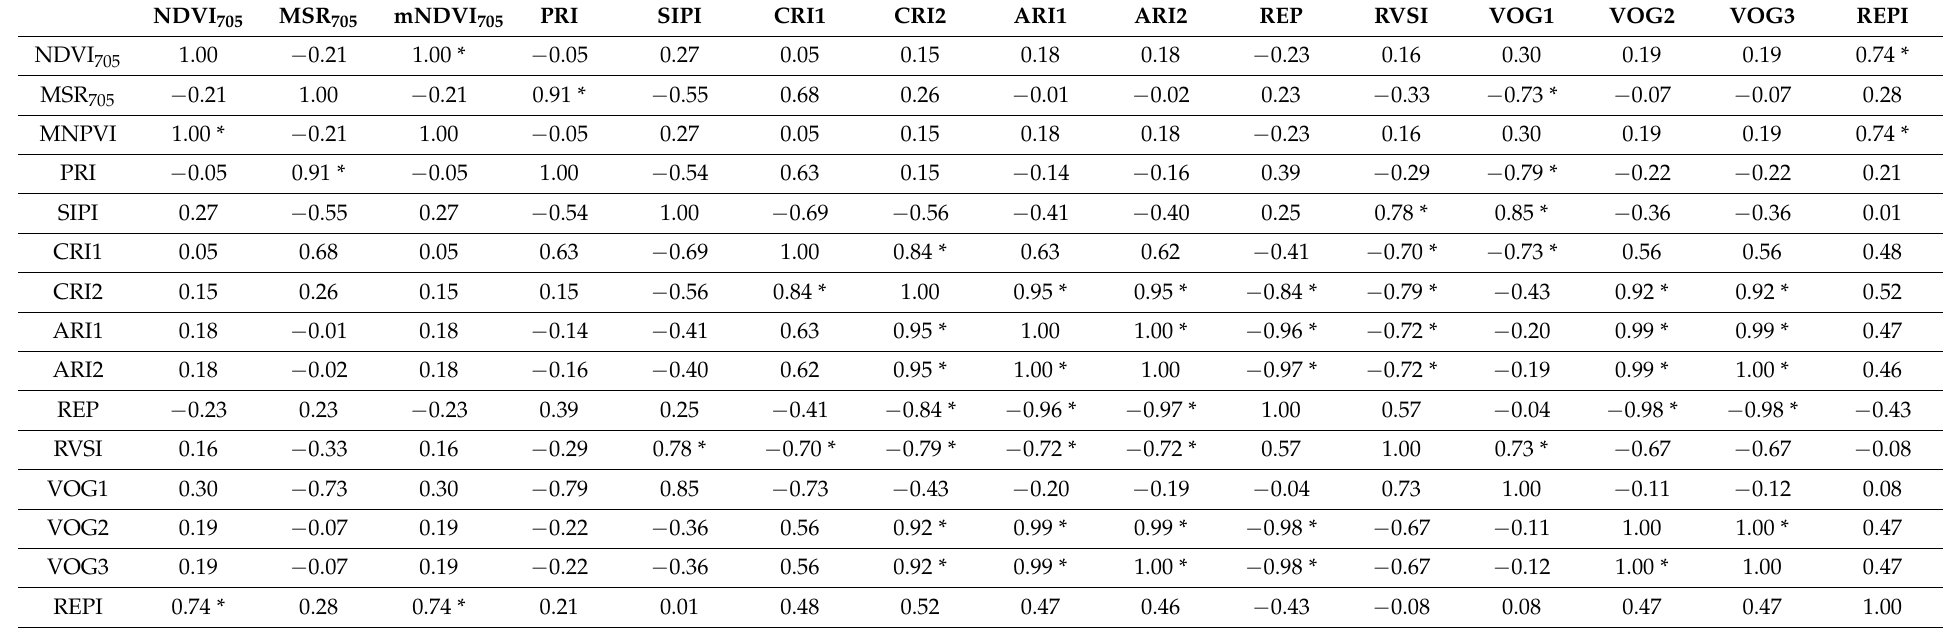
Table 4. Correlation structure of dependence of values of vegetation